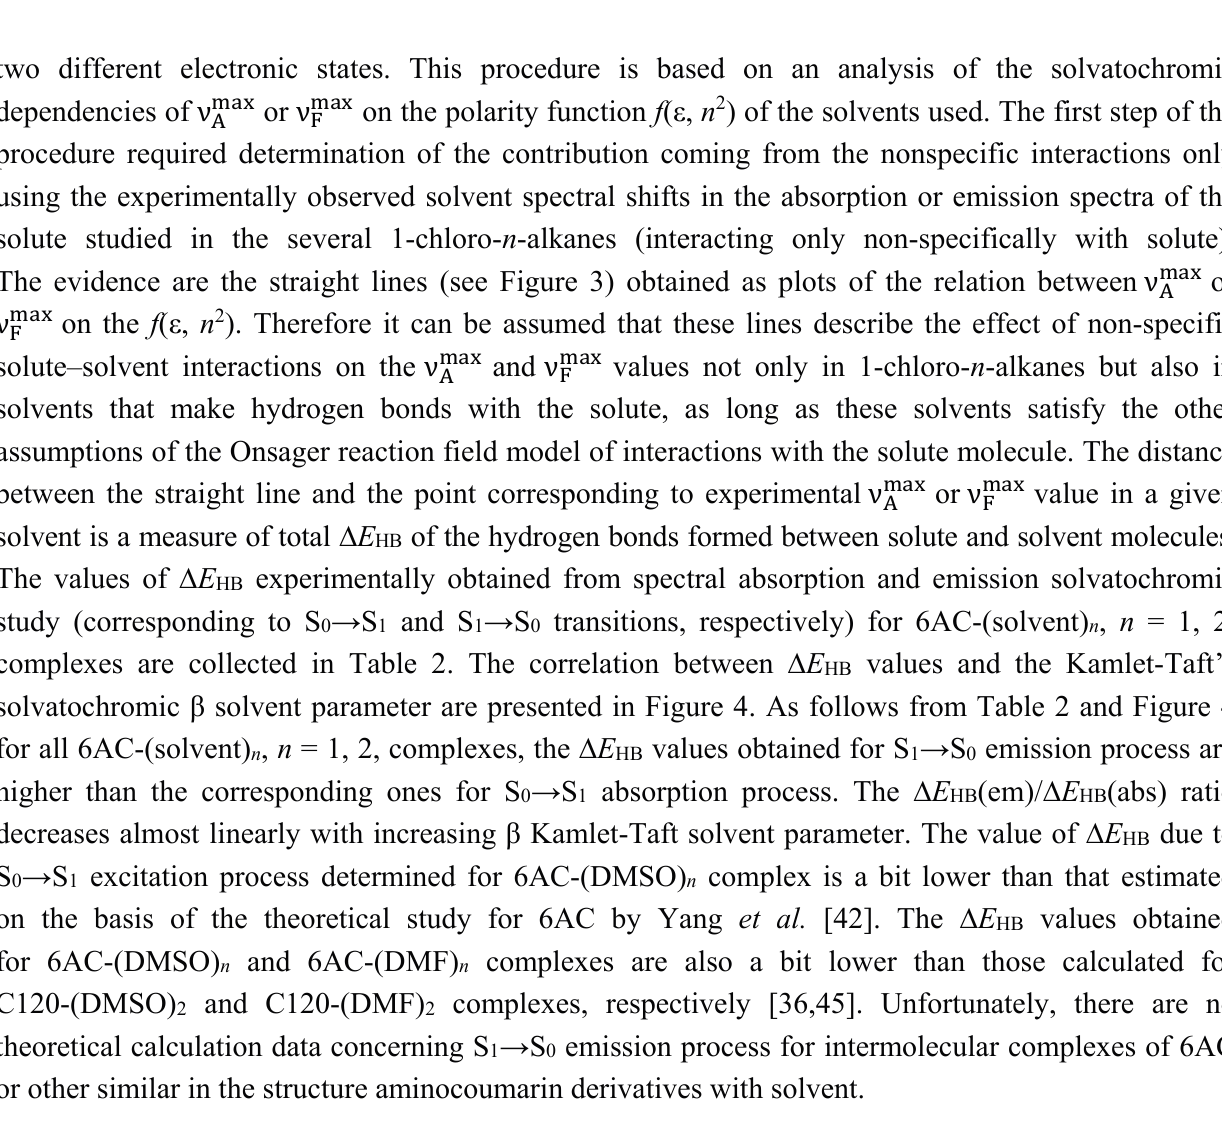
Table 2. Hydrogen bond energy changes for 6AC-(solvent) n , n = 1, 2, complexes as